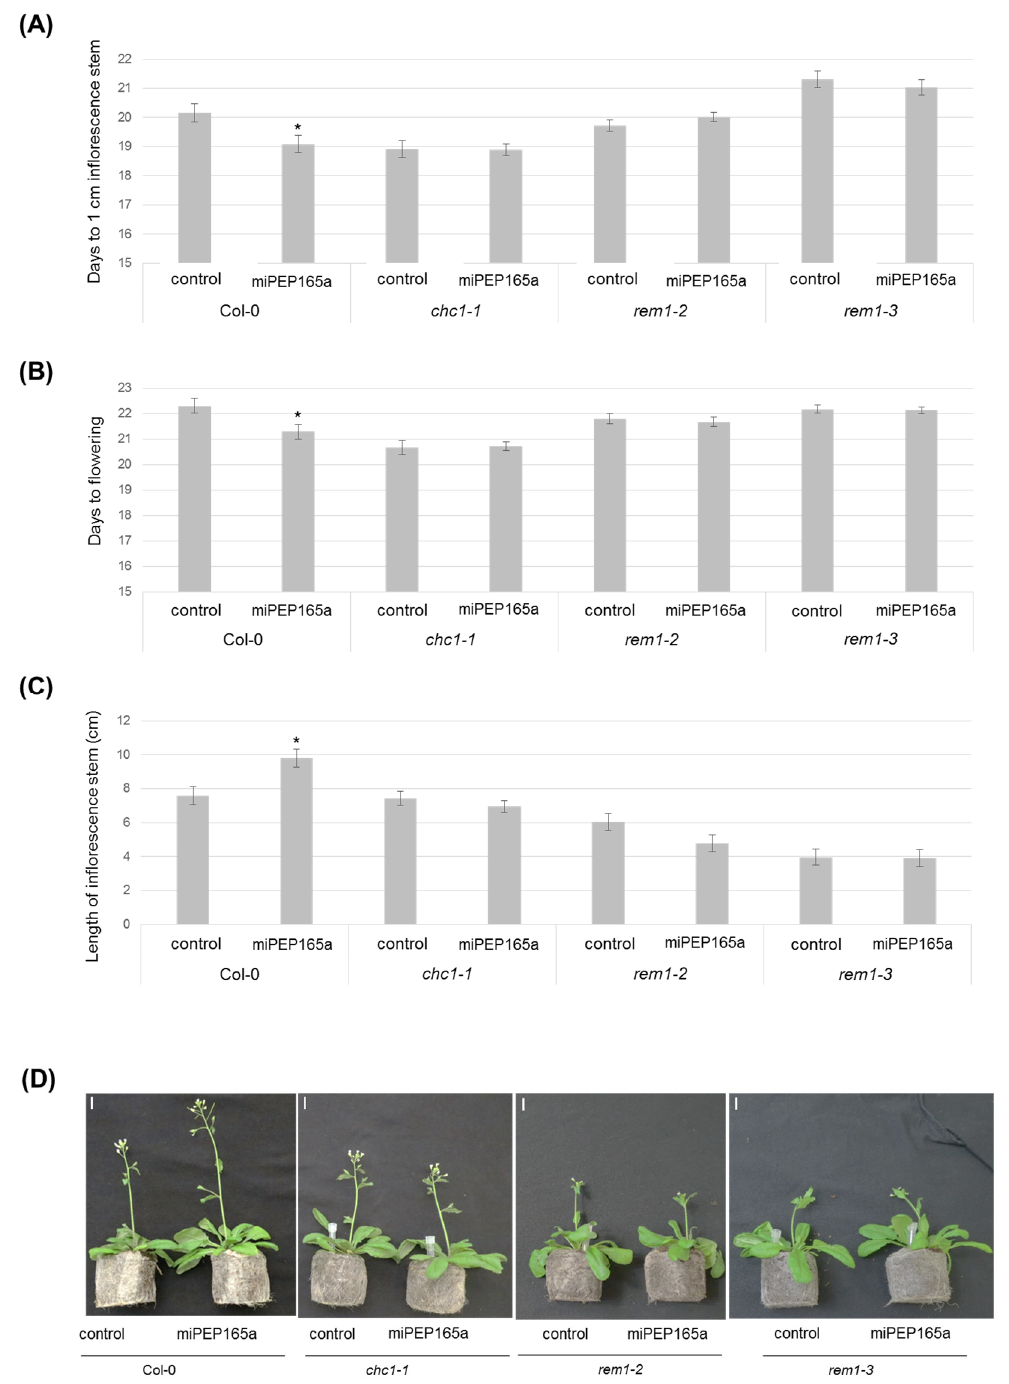
Figure 7. Flowering time depends on clathrin- and membrane microdomain-associated pathways. The number of days to obtain a 1-cm inflorescence stem ( A ) and the number of days to observe the first flowers ( B ) were determined for wild-type plants as well as for chc1-1 , rem1-2 , and rem1-3 mutant plants. ( C ) Measurement of the inflorescence stem length was determined 24 days after sowing for wild-type and mutant plants. Data are representative of the average of at least four independent experiments with at least 10 plants per condition, for each experiment. Error bars represent SEM and statistical analyses were performed using a t-test (*, p < 0.01). ( D ) Representative images comparing wild-type and mutant plants treated with water (control) or miPEP165a. Bar = 1 cm.